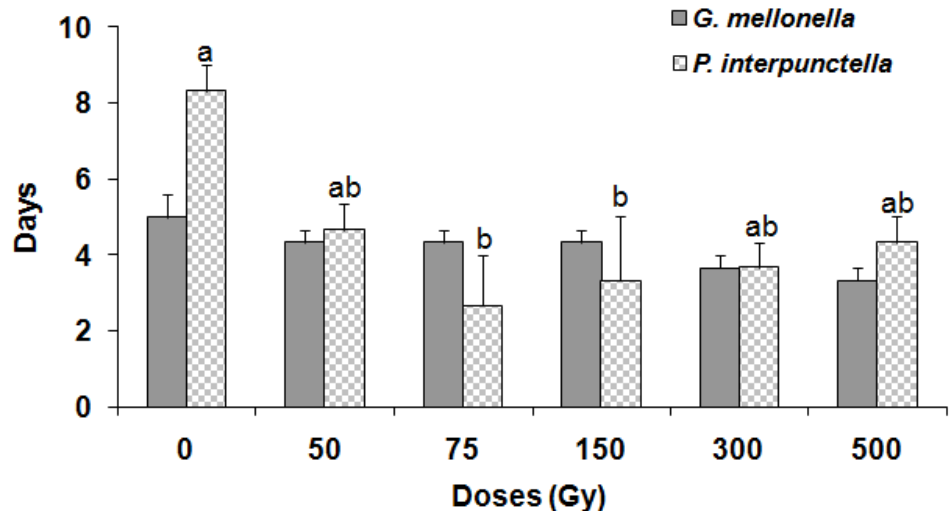
Figure 4. Female sex ratio ( ± SE) of parasitoid H. hebetor developing from the irradiated larvae of G. mellonella and P. interpunctella. (Bars followed by the same letters of a, b, c, A, B are not significantly different at 0.05 by Tukey’s test; lowercase letters for G. melonella , uppercase letters for P. interpunctella ).